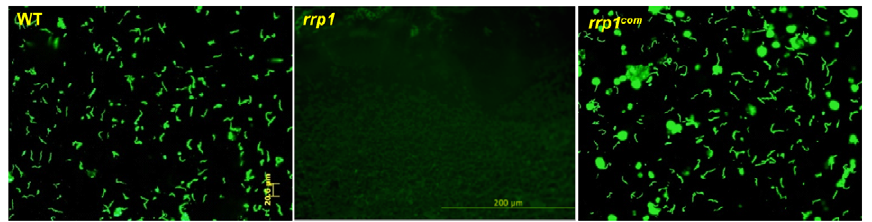
Figure 3. The rrp1 mutant could not survive in artificially infected ticks upon feeding. Unfed I. scapularis nymphs were microinjected with wild-type (5A4NP1), rrp1 , or rrp1 com spirochetes and then fed on naı¨ve mice. The engorged nymphs were collected after repletion and subjected to IFA analysis using fluorescein isothiocyanate-labeled anti- B. burgdorferi antibody. Ten ticks were examined in each group and a representative image for each group of ticks is shown in this